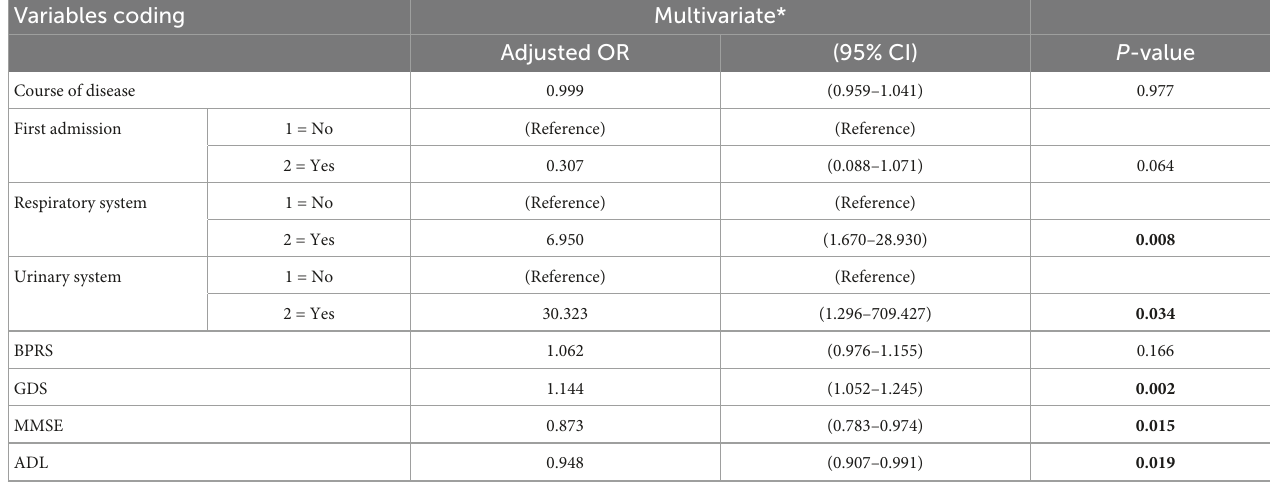
TABLE 3 Results for binomial logistic regression, displaying adjusted odds ratios and 95% confidence intervals for functional impairment. Variables